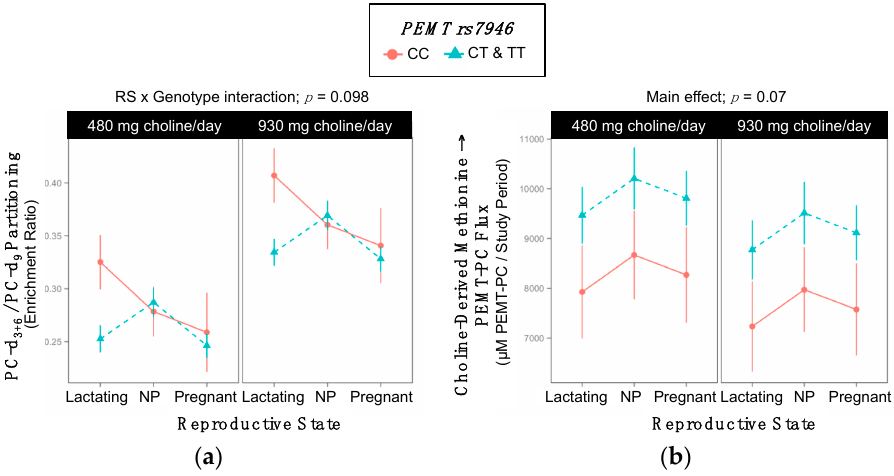
Figure 7. Effect of the PEMT rs7946 variant on the metabolic flux and partitioning of dietary choline. ( a ) PC-d 3+6 /PC-d 9 partitioning; ( b ) Choline-derived methionine → PEMT-PC flux. Table 11. Comparison of PC-d3+6/PC-d9 enrichment ratios between PEMT rs7946 genotype by reproductive state. Values are least-squared means ± standard errors.